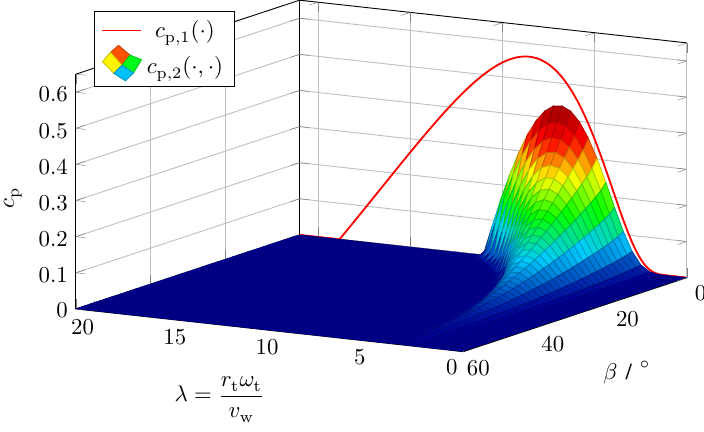
) and c p,2 ( ) for a 2MW , · · ·